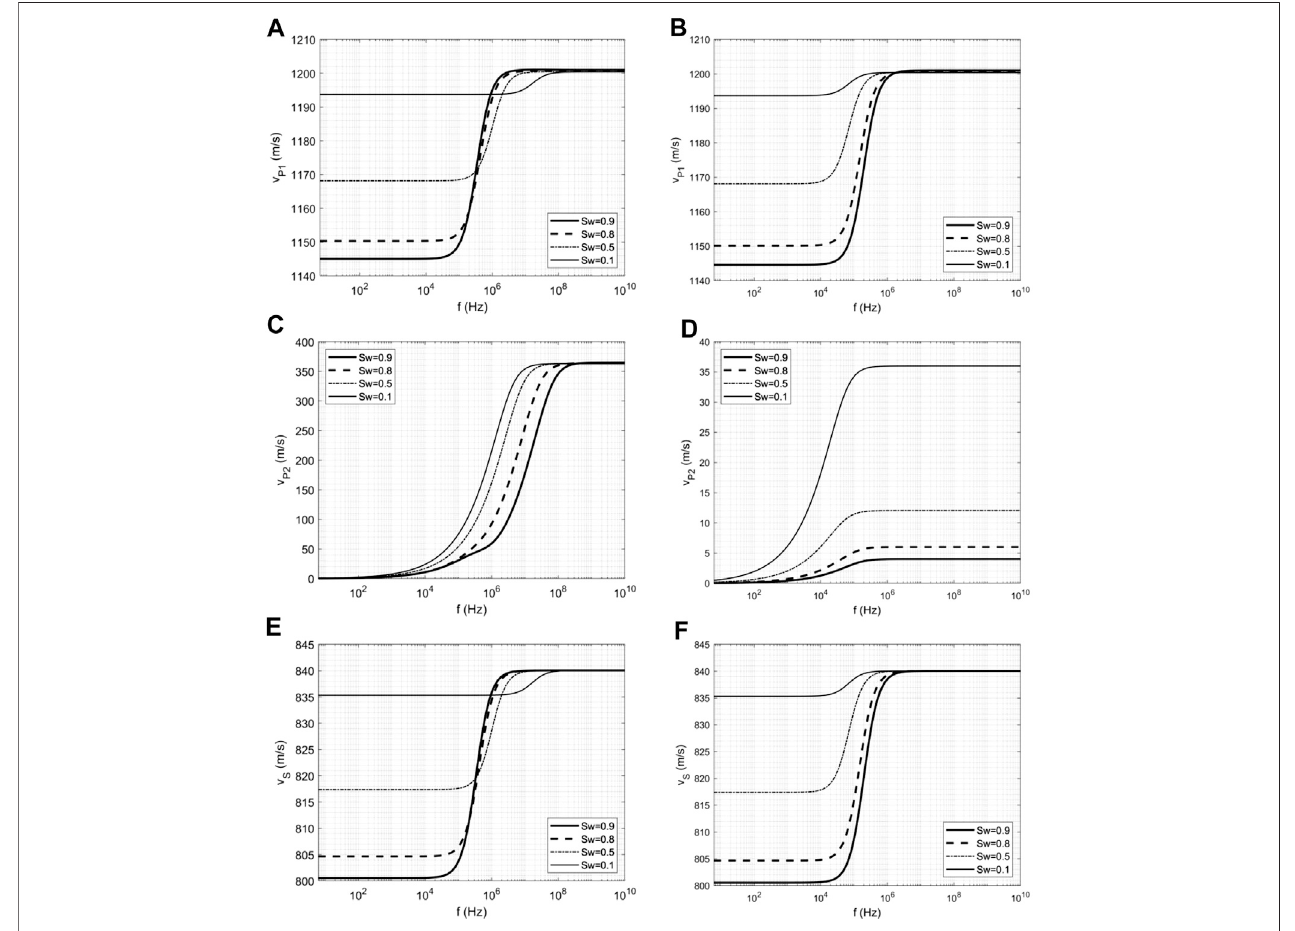
FIGURE1| Thedispersioncurveofseismicwavepropagation inporousmediacontaininggasand water: (A,C,E) arethedispersion curvesofthefastP-wave,the slow P-wave and the S-wave corresponding to four saturations calculated by Eq. 1 , respectively; (B,D,F) are those of dispersion curves by the improved model proposed in this